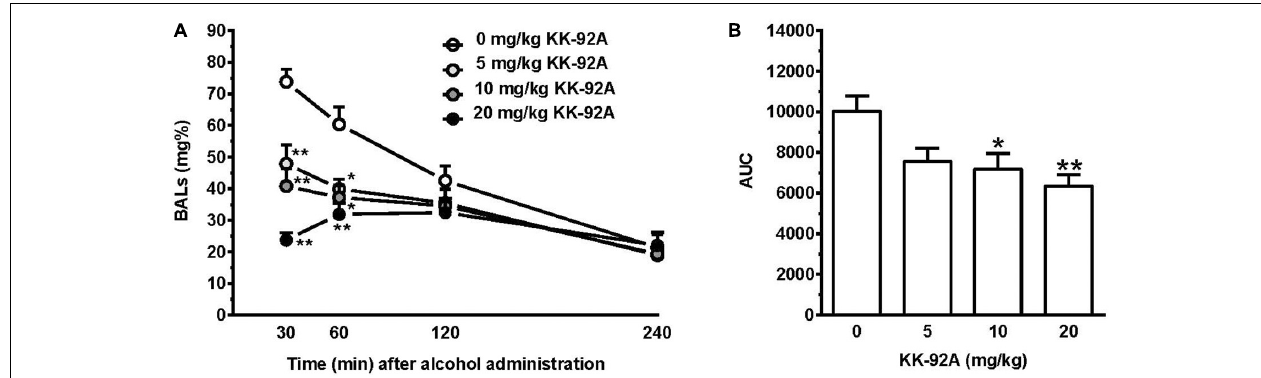
FIGURE 7 | Effect of acute pretreatment with the positive allosteric modulator of the GABA B receptor, KK-92A, on blood alcohol levels (BALs) in female Sardinian alcohol-preferring rats. Rats were initially trained to lever-respond for oral alcohol (15% v/v, in water) [Fixed Ratio (FR) 5 (FR5)] and water (FR1) in daily 30-min self-administration sessions. Once lever-responding had stabilized, KK-92A was administered intraperitoneally 30 min before the intragastric administration of 1 g/kg alcohol (15%, v/v). Blood samples were collected from the tip of the rat tail at 30, 60, 120, and 240 min after alcohol administration and analyzed by means of an enzymatic system. In panel (A) , BALs were expressed in mg%. Each point is the mean ± SEM of n = 10 rats. * P < 0.05 and ** P < 0.01 in comparison to the rat group treated with 0 mg/kg KK-92A at the corresponding time (Tukey’s test). In panel (B) , data on the area under the curve of BAL time-course are expressed as (h* µ g/ml). Each bar is the mean ± SEM of n = 10 rats. * P < 0.05 and ** P < 0.005 in comparison to the rat group treated with 0 mg/kg KK-92A (Tukey’s test).